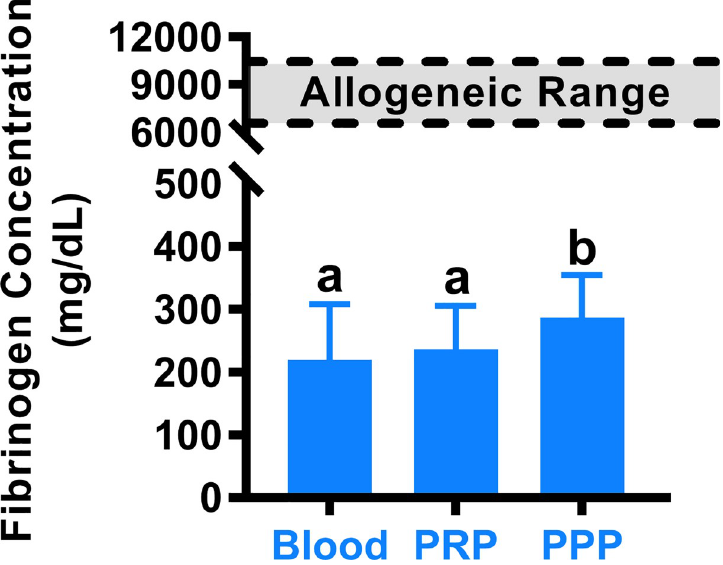
Fig 3. Fibrinogen concentrations for autologous sources. Fibrinogen sources with different letters were statistically different. Reported concentration range for the allogeneic fibrinogen source (Tisseel) was 6,700–10,600 mg/dL and is represented by shaded bar on